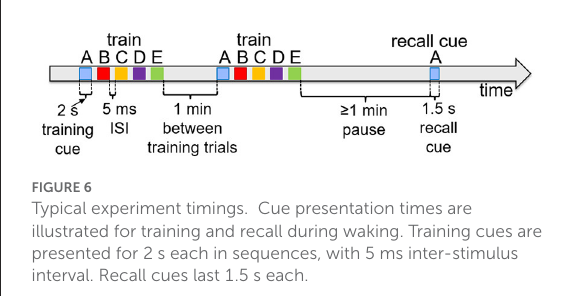
FIGURE6 Typical experiment timings. Cue presentation times are illustrated for training and recall during waking. Training cues are presented for 2 s each in sequences, with 5 ms inter-stimulus interval. Recall cues last 1.5 s